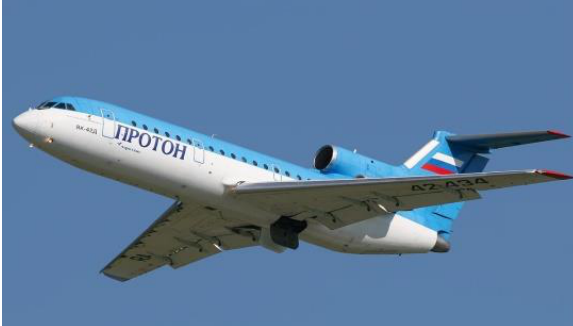
Figure 6. The outline of Yak-42. Parameters of the radar are 5.52 GHz carrier frequency, 100 Hz pulse repetition frequency, and 400 MHz bandwidth. We added white Gaussian noise (SNR = 5 dB and 0 dB) and MTRC to the data and compared our proposed method with range-Doppler